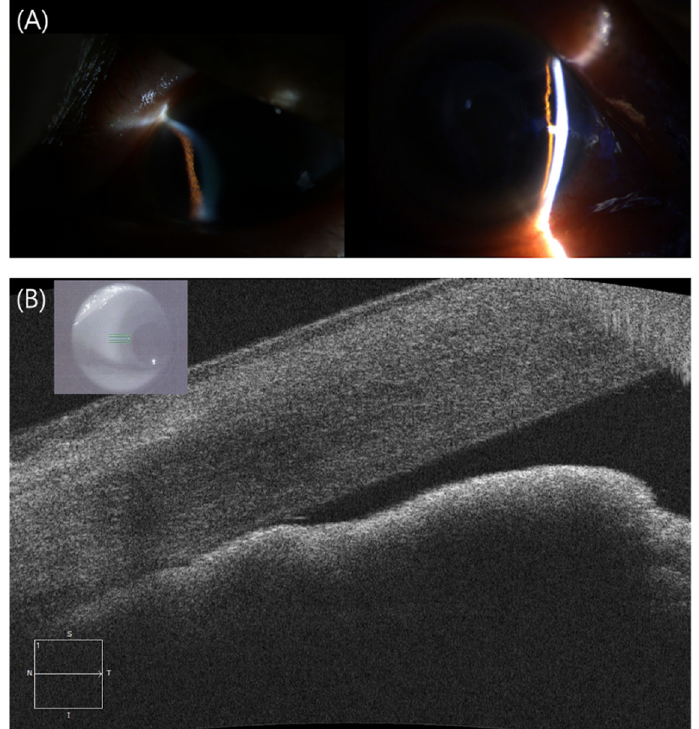
Figure 3. (Patient 14) A 71-year-old woman with hypertension presented to the emergency depart- ment with a two-day history of pain and redness in the left eye (visual acuity 20/50). ( A ) An oph- thalmic examination revealed a high IOP of 36 mmHg associated with shallowing of the anterior chamber peripherally in the left eye. ( B ) Anterior-segment OCT images show anterior bowing of the peripheral iris and closing of the iridocorneal angle in the left eye. Her axial length was 21.86 mm in the right eye and 21.84 mm in the left eye, and her spherical equivalents were −1.13 and −3.63 diopters, respectively. An acute attack of angle closure was diagnosed, and treatment with laser peripheral iridotomy was attempted but failed. The next day, phacoemulsification with goni- osynechialysis was performed and her IOP dropped to 7 mmHg .